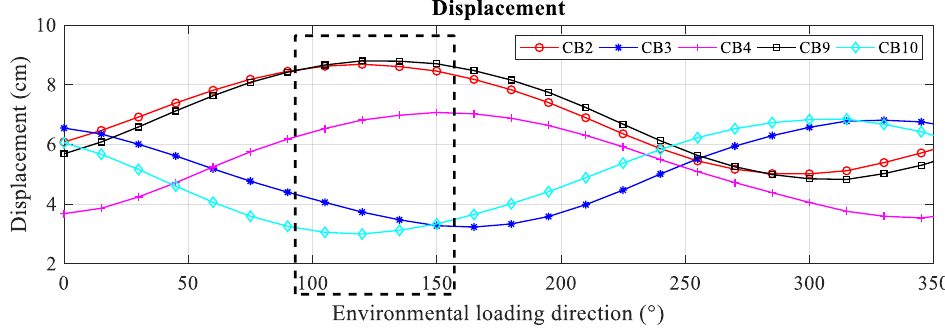
Figure 9. Lateral displacements at IP under combined loads.